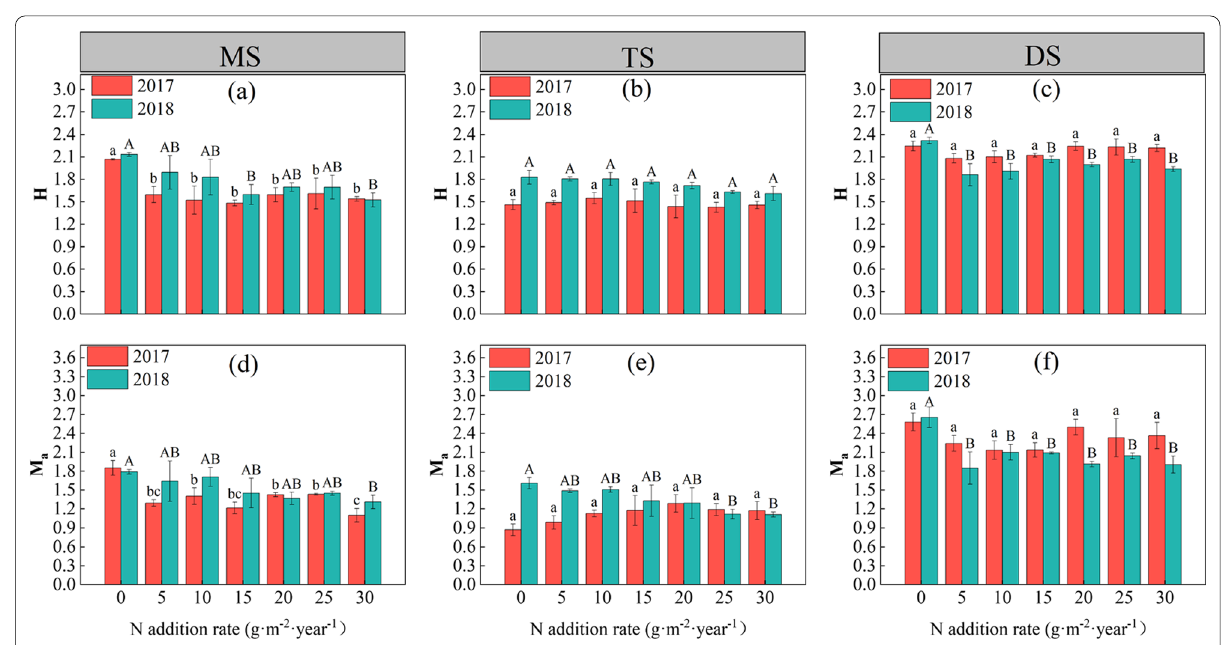
Fig. 3 Effects of experimental N addition on the Shannon-Wiener (( a ) MS, ( b ) TS, ( c ) DS) and Margalef richness (( d ) MS, ( e ) TS, ( f ) DS) of